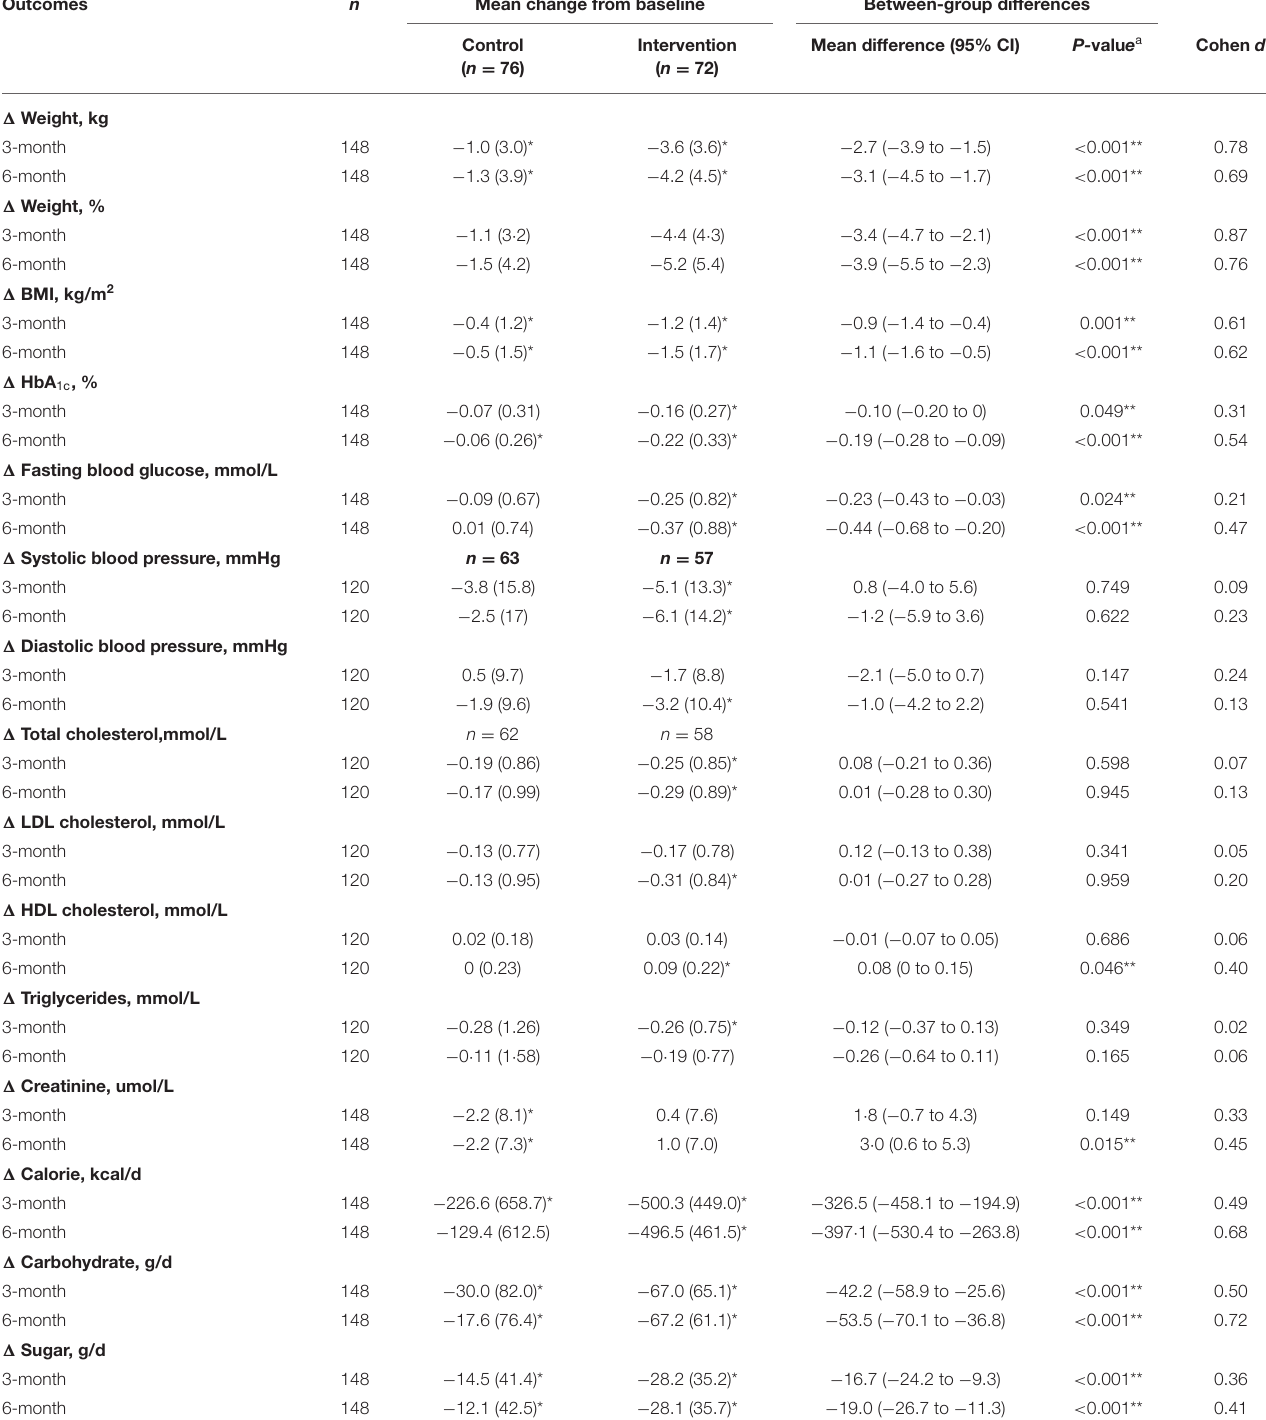
TABLE 2 | Primary and secondary outcomes at 3 and 6 months post-enrollment.